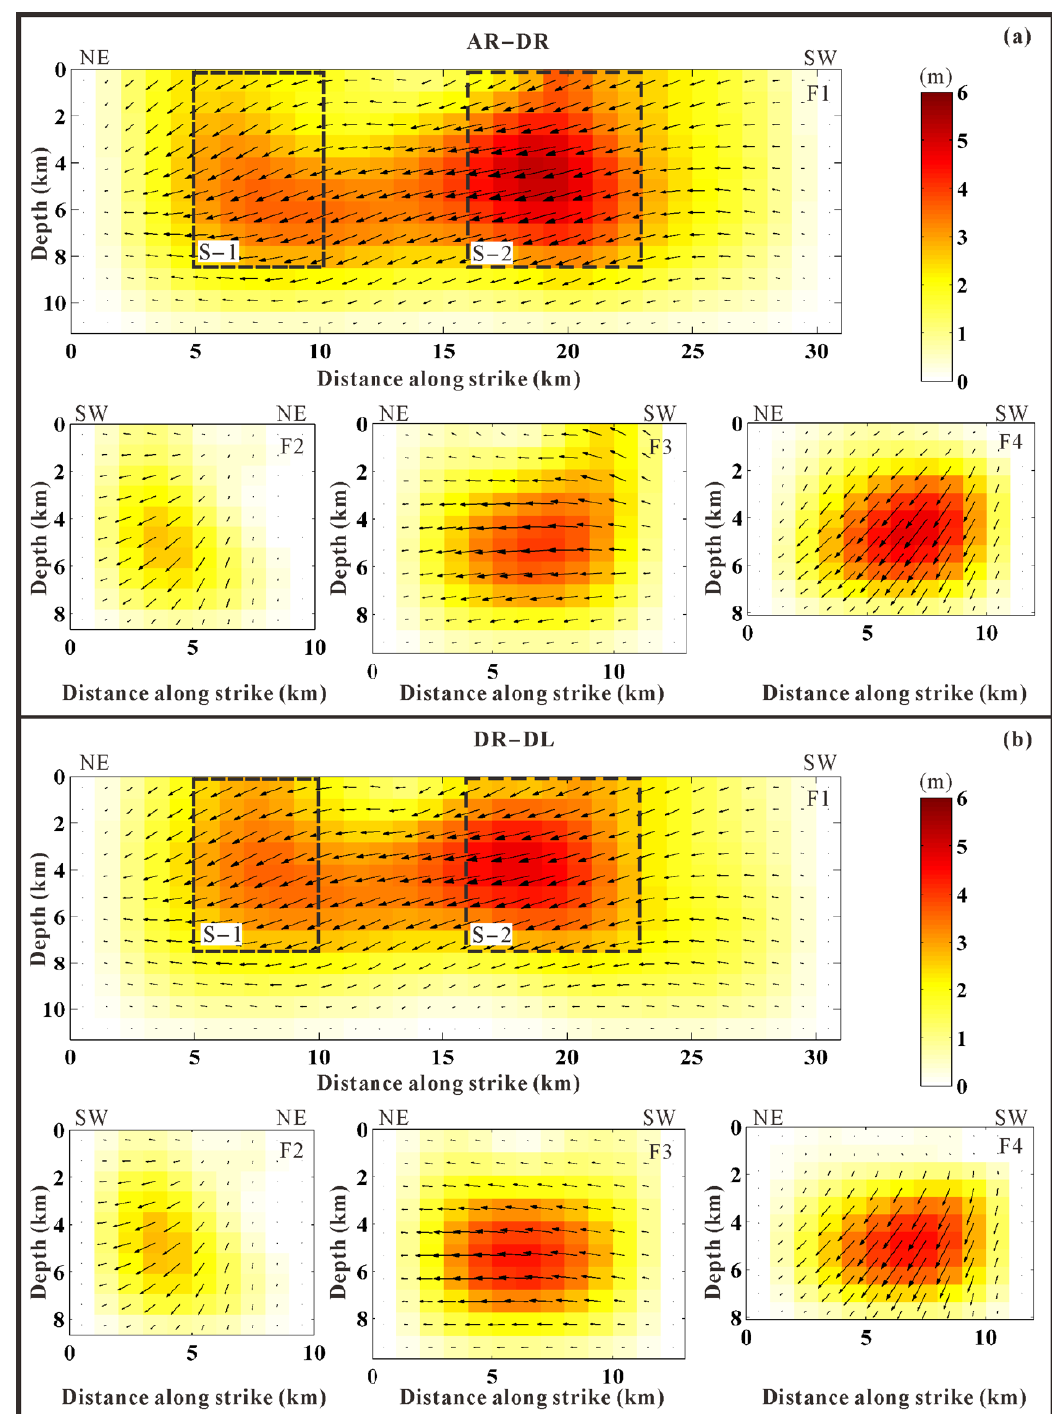
Figure 4. Fault slip models of the Kumamoto earthquake constrained by different ground deformation date sets. ( a ) Coseismic slip distribution solved by the right-looking only data of AR–DR. ( b ) Coseismic faulting model derived from the joint constraints of the right- and left-looking data of DR–DL. Black dotted rectangles denote the high slip concentrations on F1. Arrow vector indicates the direction and magnitude of the slip on each sub-fault patch.